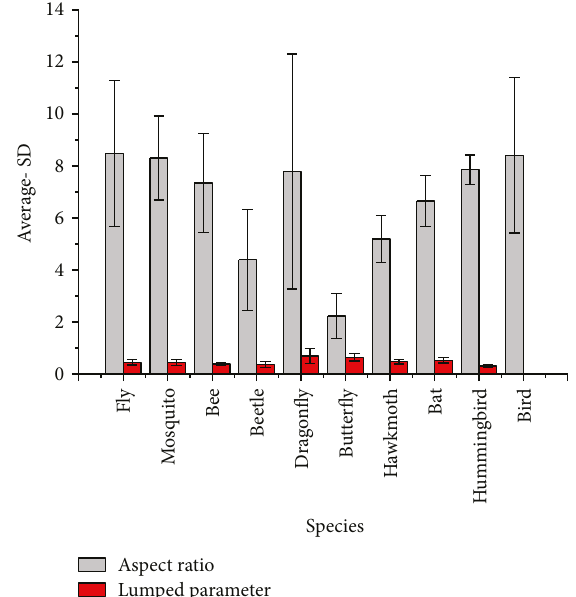
Figure 8: Lumped parameter and aspect ratio in natural